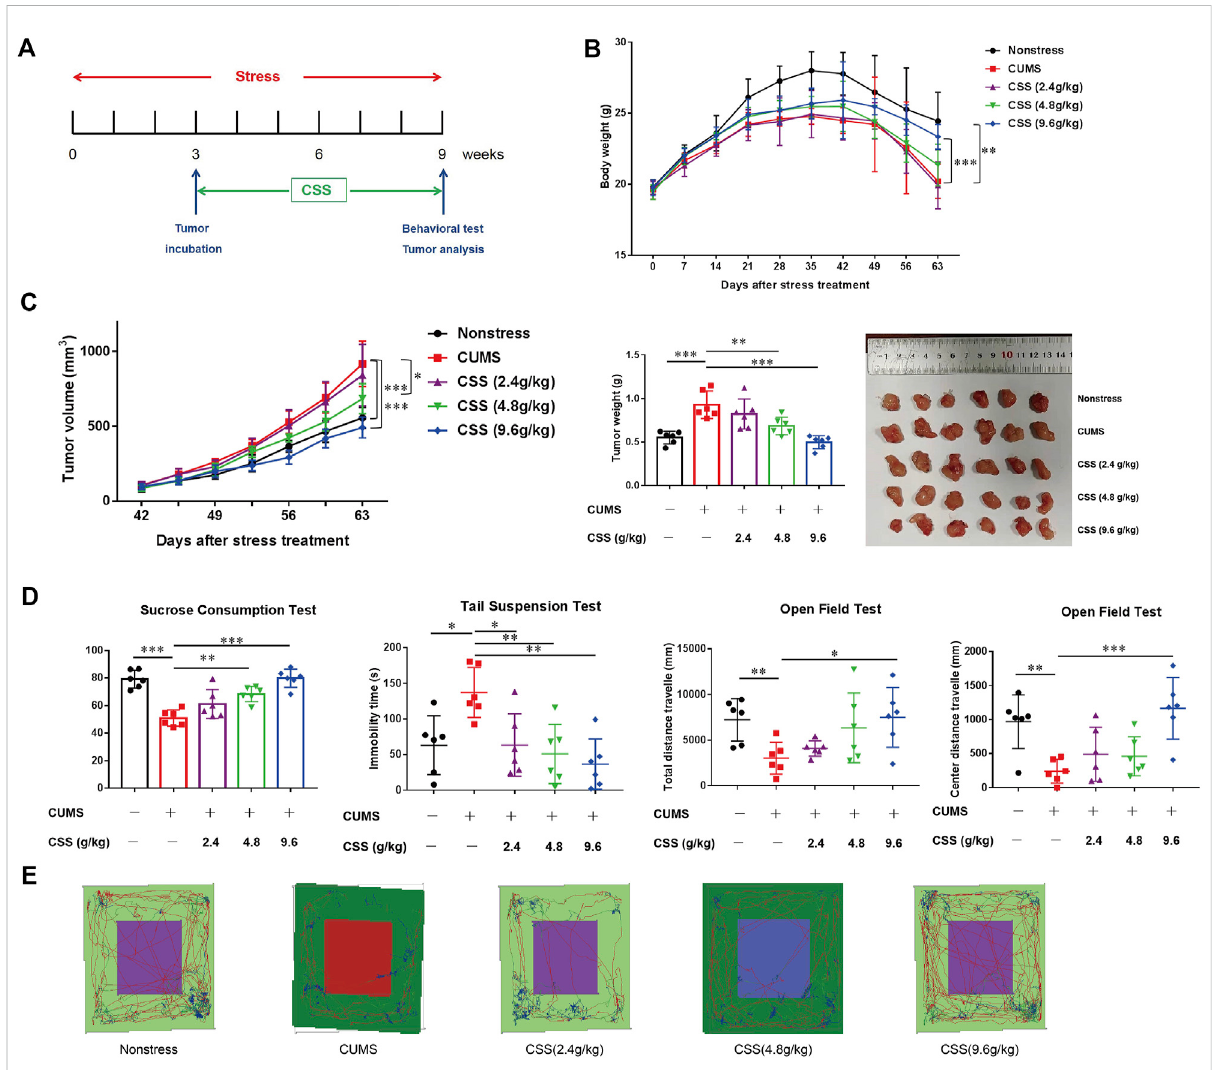
FIGURE 1 CSS prevents CUMS-promoted tumor growth in the PCa model. (A) Time course of restraint stress and tumor implantation. (B) Body weight of mice( n =6).ThestatisticalanalysiswasbasedonTwo-wayANOVA(Non-stressvs.CUMS,fromweek4toweek9,** p < 0.01;CUMSvs.CSS9.6 g/kg, fromweek9, *** p < 0.001). (C) Tumorvolume, tumorweight and tumorphoto ofmice ( n = 6).Thestatisticalanalysis oftumor volumewasbased on Two-way ANOVA (Non-stress vs. CUMS, from week 8 to week 9, *** p < 0.001; CUMS vs. CSS 9.6 g/kg, from week 8 to week 9, *** p < 0.001; CUMSvs.CSS4.8 g/kg,fromweek8toweek9,* p < 0.05).Thestatistical analysis oftumorweightwasbasedonOne-wayANOVA (** p < 0.01,*** p < 0.001). (D)